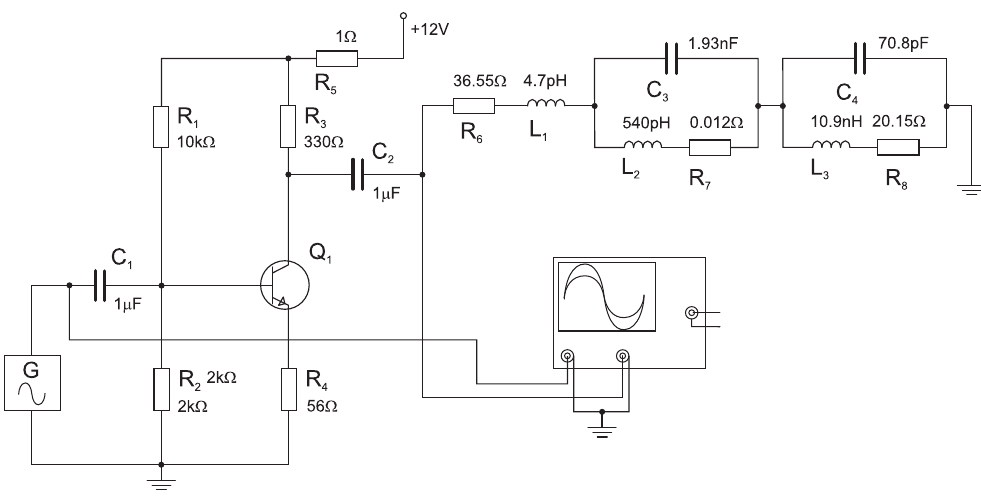
Figure 9. A-class amplifier with load.